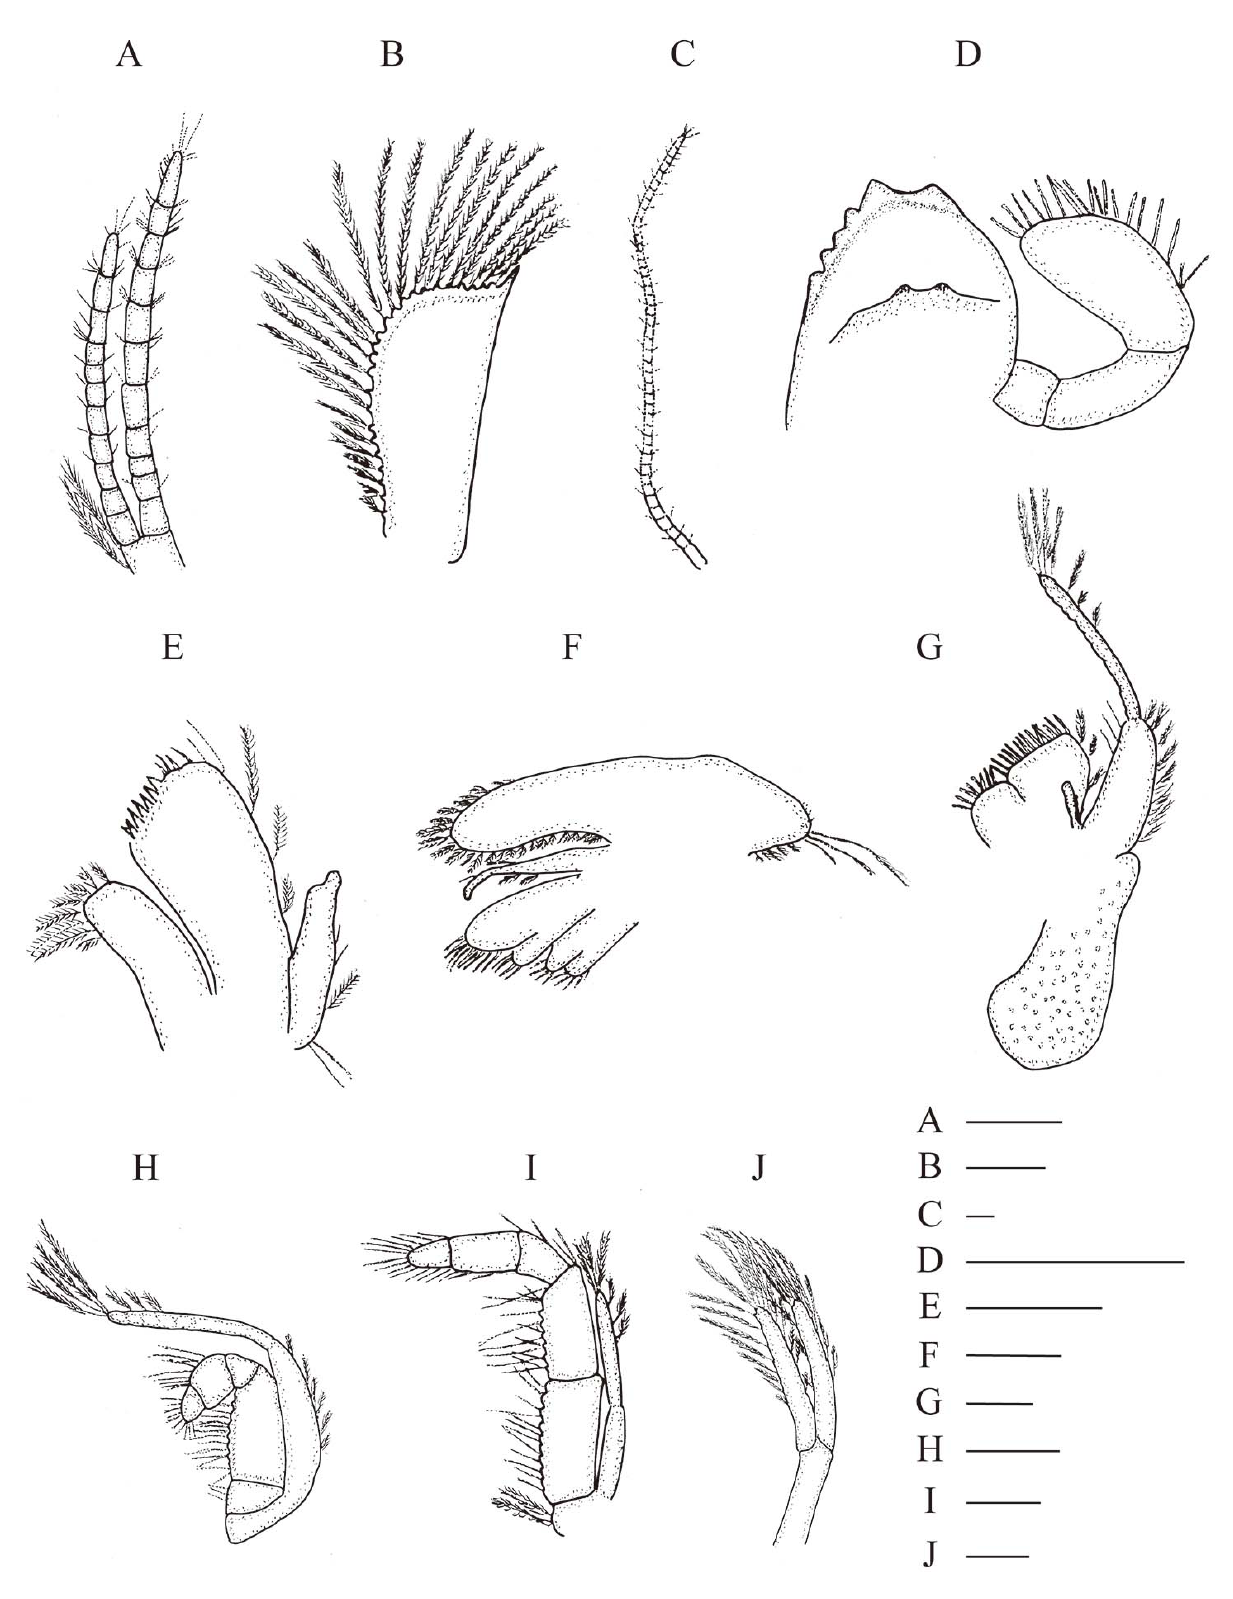
Figure 24. Juvenile Stage III of Cherax destructor . ( A ) Antenna 1, dorsal view; ( B ) antennal scale, dorsal view; ( C ) flagellum of antenna 2, dorsal view; ( D ) mandible, view of inside of mouth; ( E ) maxilla 1, oral view; ( F ) maxilla 2, oral view; ( G ) first maxilliped, oral view; ( H ) second maxilliped, oral view; ( I ) third maxilliped, oral view; ( J ) pleopod. Scale bars: 0.25